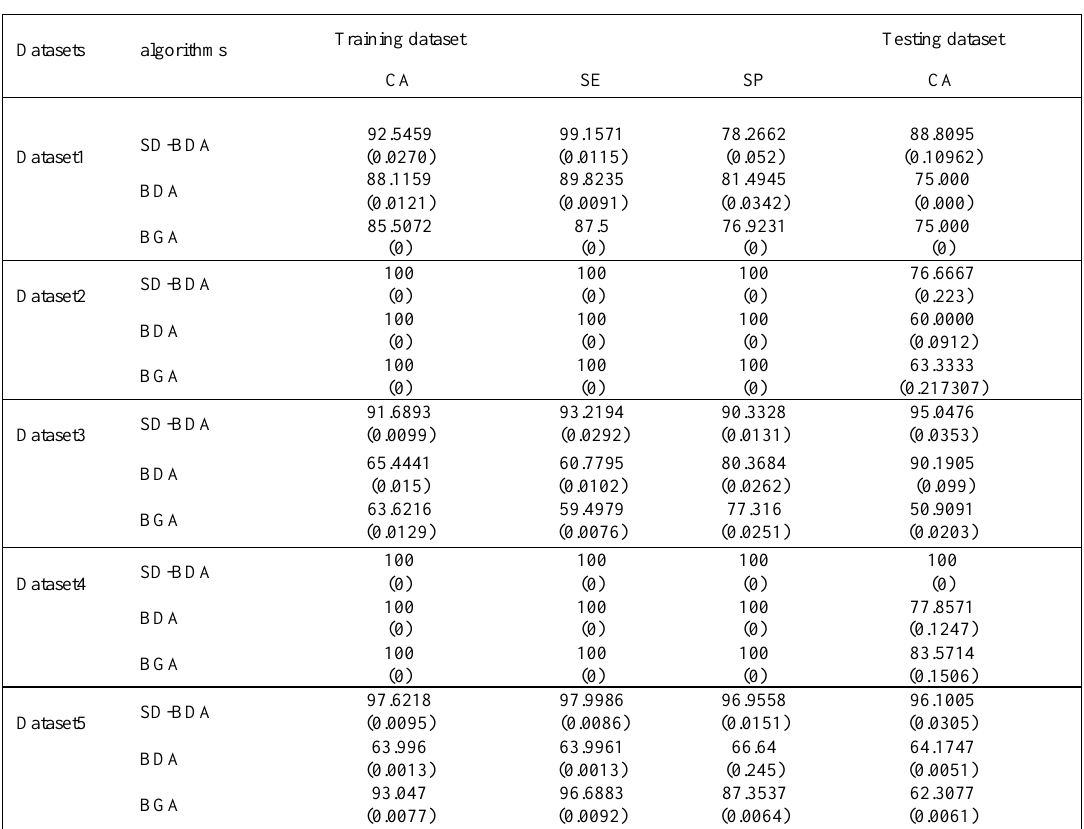
Table 3. Experimental results, on average, of the SD-BDA, BDA, and